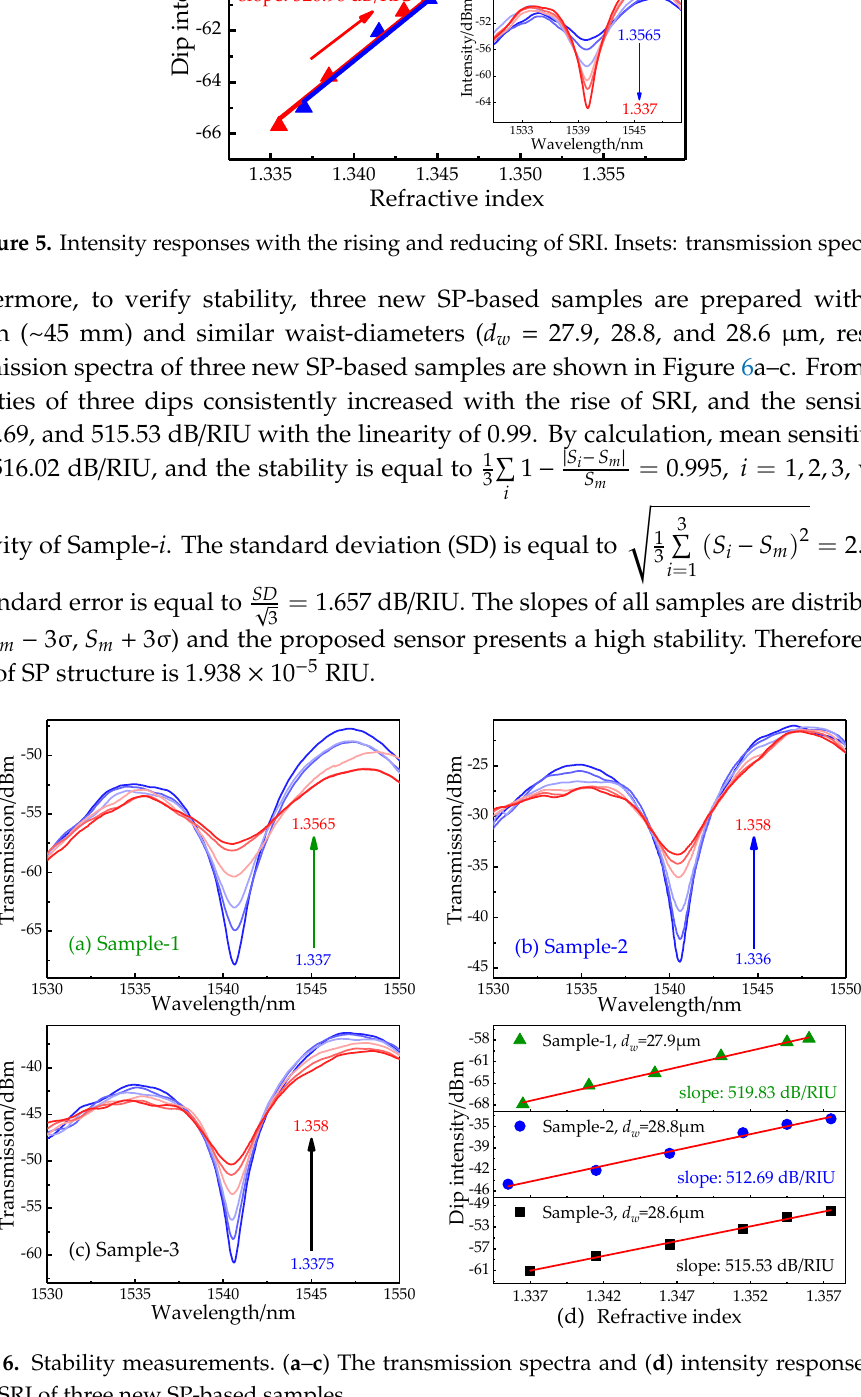
employed. Figure 7. The wavelength and intensity responses with varied temperature. Inset: transmission spectra of SP structure. Furthermore, to further enhance sensitivity, the sensing characteristics of TMDM with double-pass (DP) structure are experimentally performed. As shown in Figure 8, in DP structure, the light beams will be reflected by a well-cut end-face of DCF and pass through the taper area again. This surely